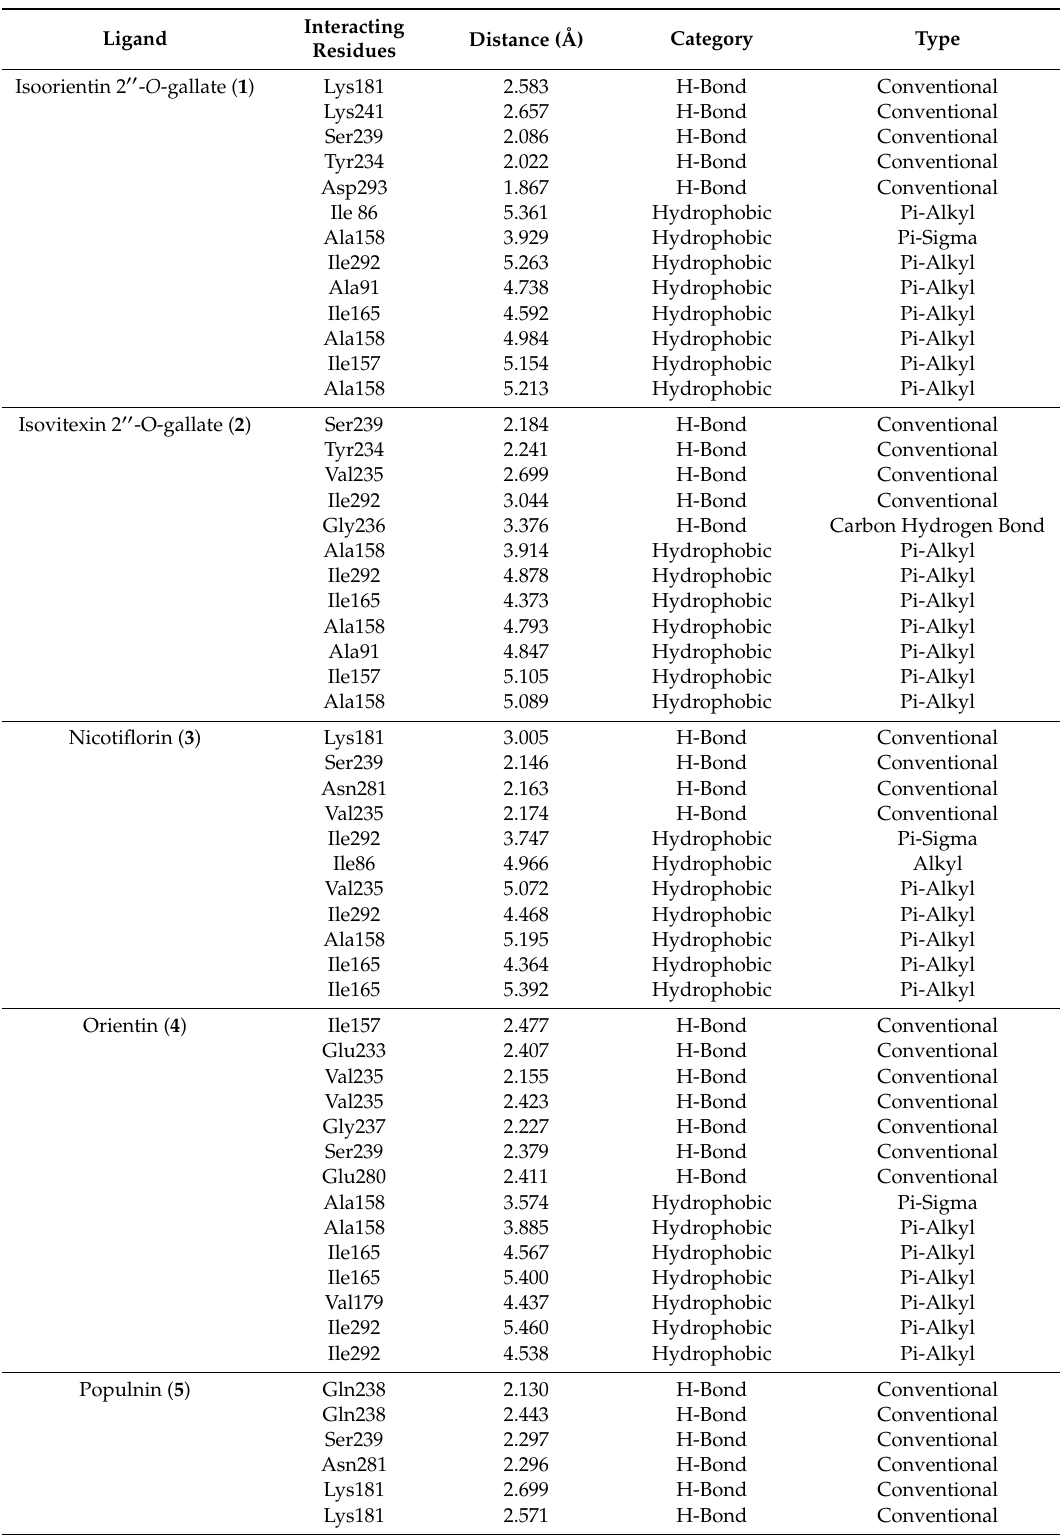
Table 4. Detailed molecular interactions obtained following the flexible ligand docking of Pelargonium compounds ( 1 ) to ( 5 ), with Mt